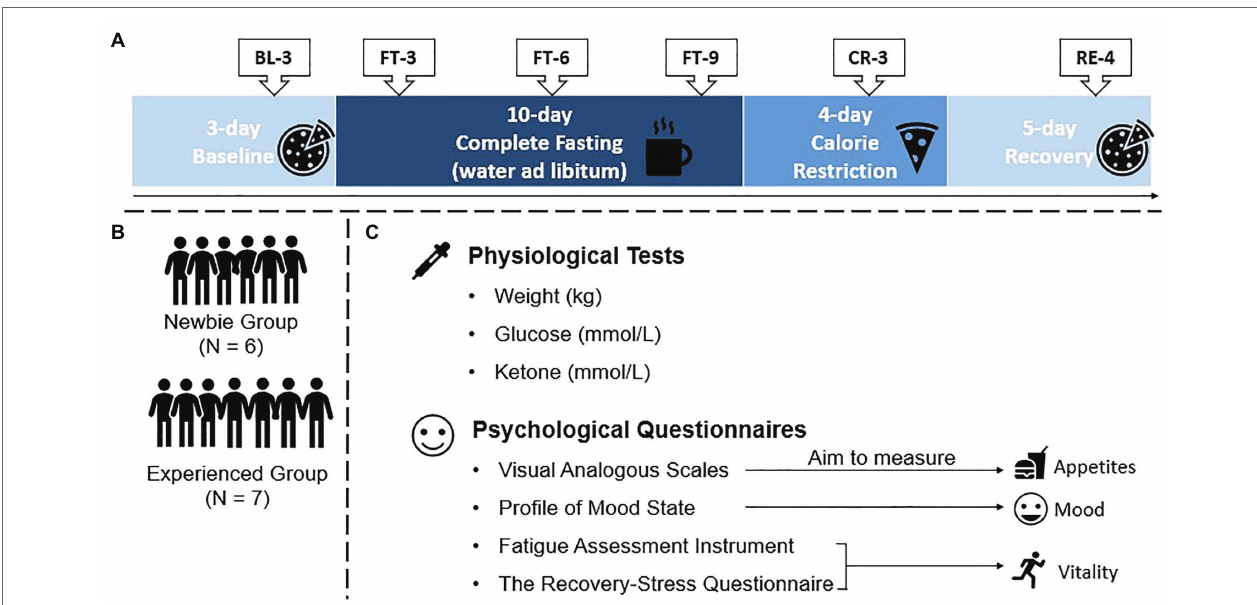
FIGURE 1 | Protocol of the 22-day experiment, test points, groups, and materials. (A) Protocol and test points (BL-3: 3rd day of Baseline; FT-3, FT-6, FT-9: 3rd, 6th, and 9th days of Complete Fasting, respectively; CR-3: 3rd day of Calorie Restriction; and RE-4: 4th day of Recovery). Participants were subject to no food intake limitations in the Baseline and Recovery sessions, they could drink water without solid food intake during the Complete Fasting session, and they could obtain limited food from the researchers during the Calorie Restriction session. (B) Two groups involved in the current experiment. (C) Physiological and psychological tests used in the current experiment for all six test